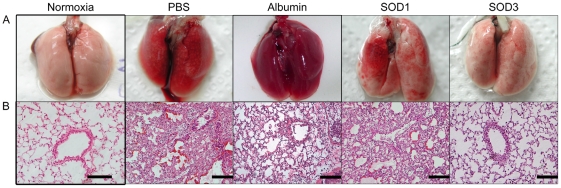
Effects of aerosolized CuZn-SOD and rhEC-SOD on lung morphology after 96 h of hyperoxia.Effects are shown as overview of full lung organ (A), and histological lung section with H&E staining (B). The control group of mice fed in normal oxygen condition (Normoxia) was shown in left panel. Following by inhalations of PBS, Albumin, SOD1 (CuZn-SOD), and SOD3 (rhEC-SOD) treated groups (n = 6 in each group) under the hyperoxia condition (FiO2>95%). The scale bars represent 500 µm.